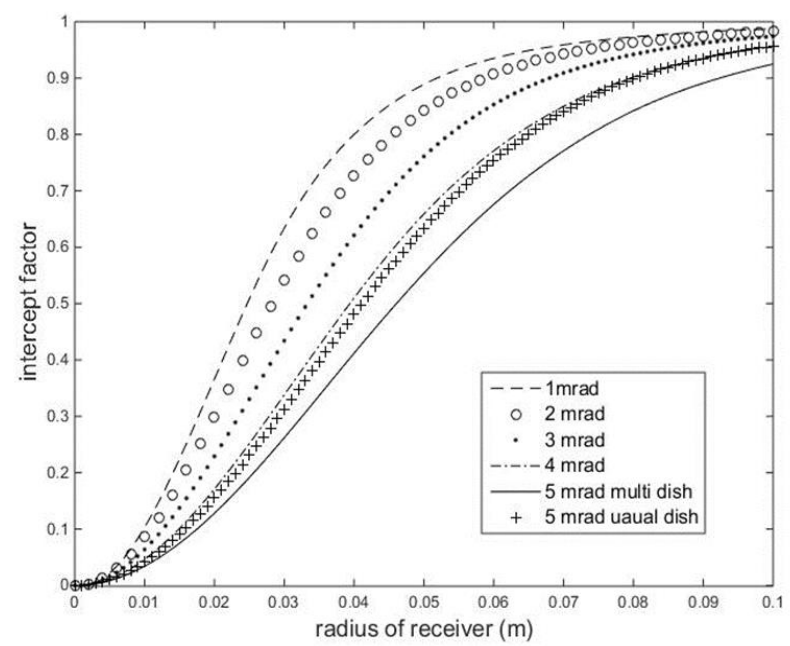
Figure 7. Variation of the system intercept factor with the receiver radius under 1 – 5 mrad optical error, when the system focal length is 5 m (f x = f p ).